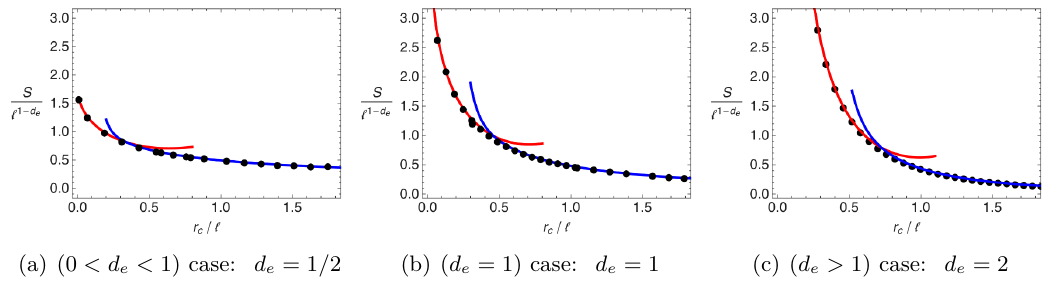
Figure 2 . S/‘ 1 − d e vs. r c /‘ at z = 2 and r h /‘ = 5 . Dots are numerical results and solid lines are analytic results: eq. (2.11) (red; small cutoff), eq. (2.17) (blue; large cutoff).